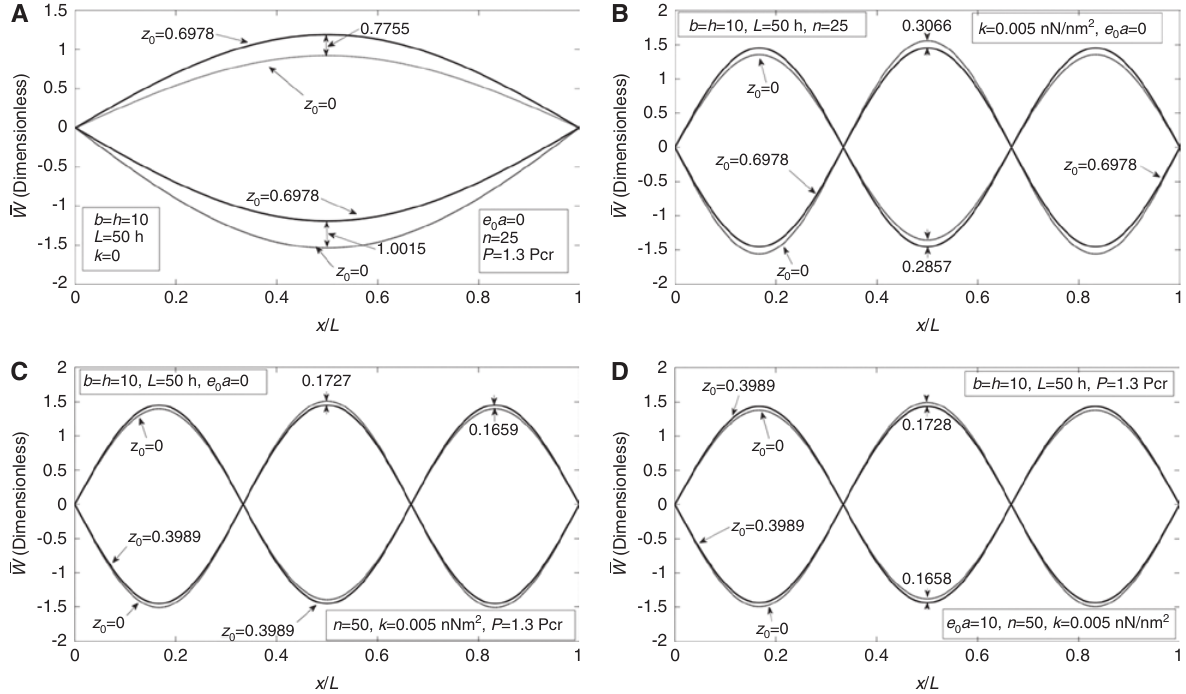
Figure 4: Effect of neutral axis position on the buckling shape of FG